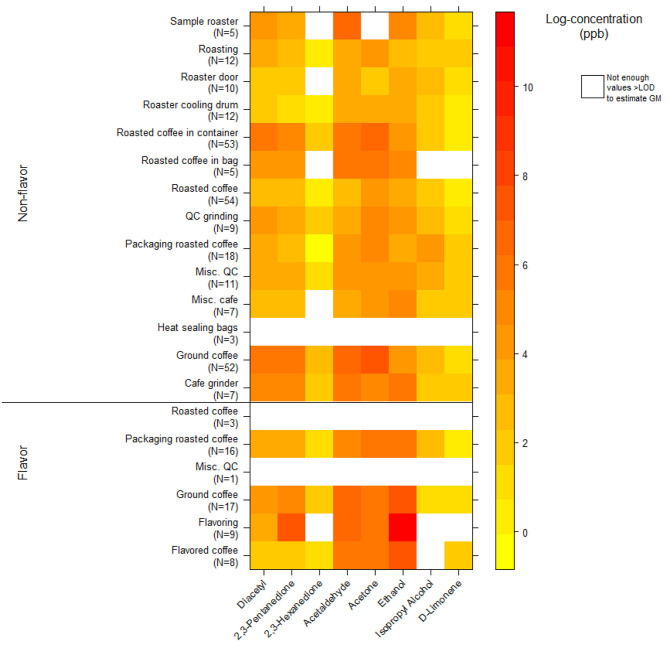
Heatmap of instantaneous area source concentrations for select VOCs (log-concentration in ppb) using canisters (NMAM 3900).